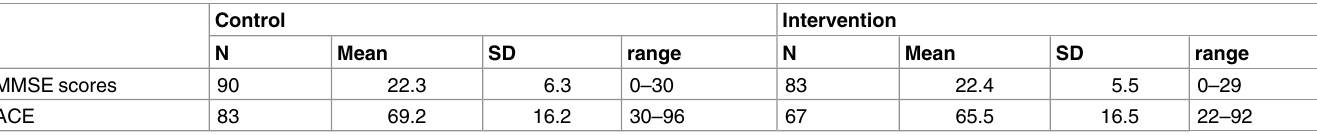
Table 2. MMSE and ACE